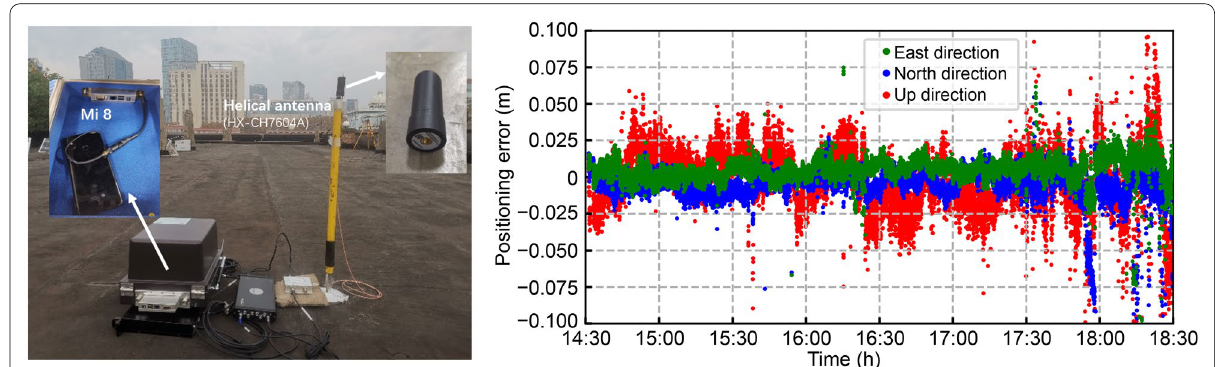
Fig. 12 Equipment sets of smart devices with the low-cost helical antenna (left panel) and PPP-RTK positioning series from 14:30 to 18:30 (right panel) (Li et al., 2022f)